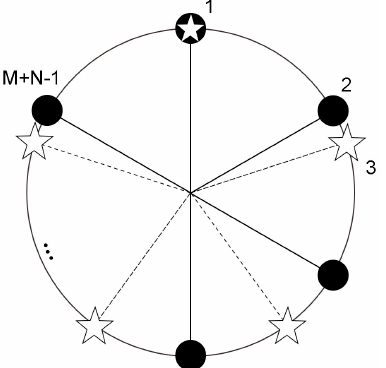
Figure 1. Co − prime circular array (CPCA) configuration.